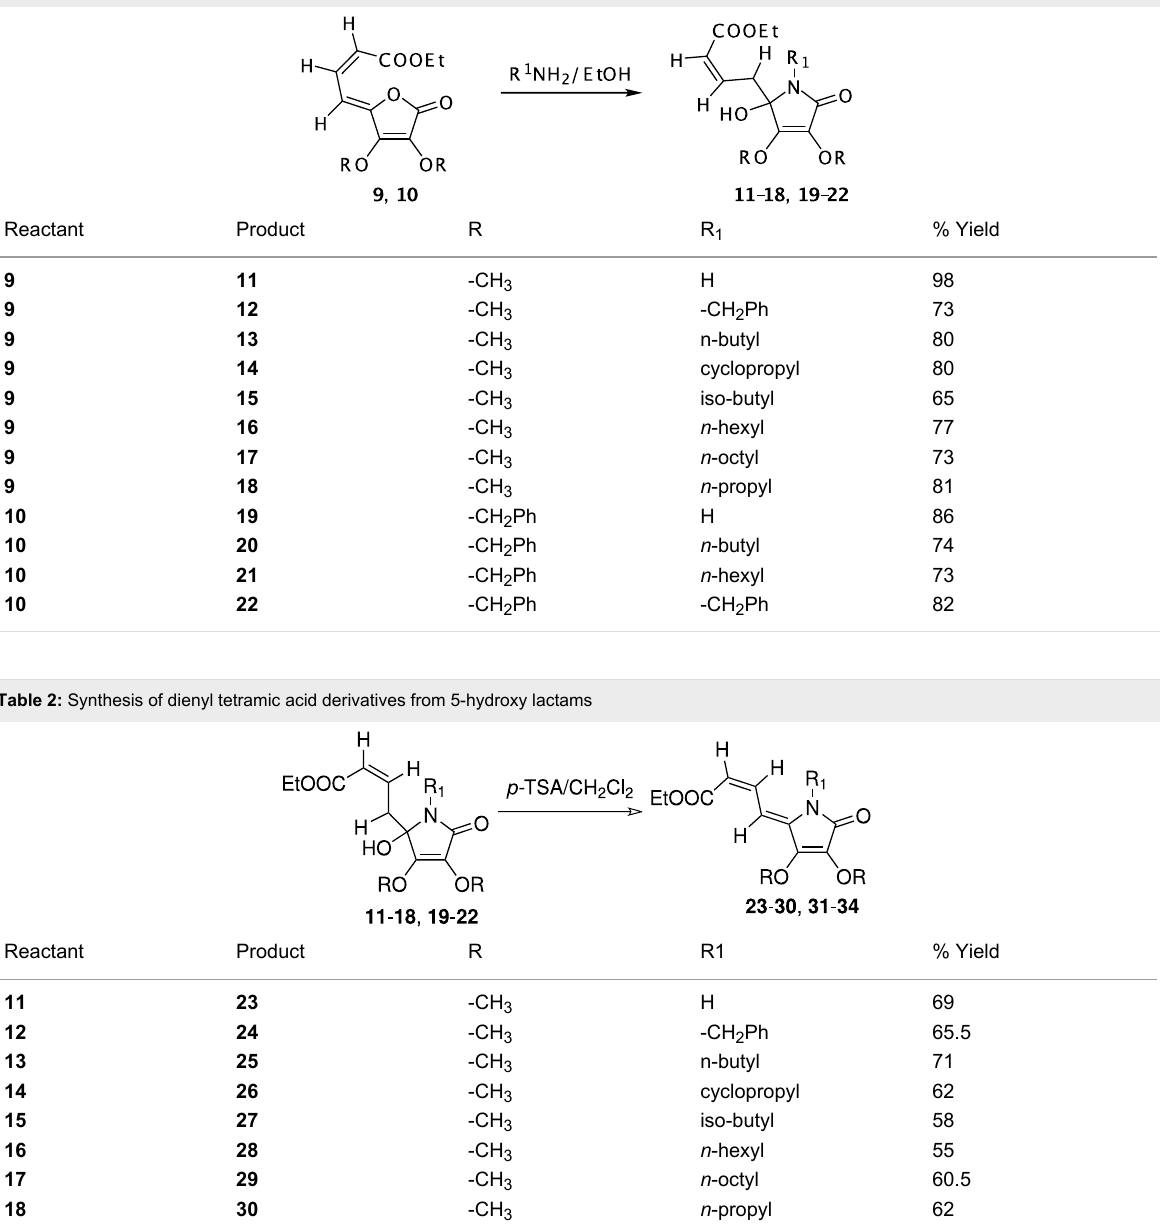
Table 1: Synthesis of 5-hydroxy lactams ( 11–22 ) from dienyl tetronic acid derivatives